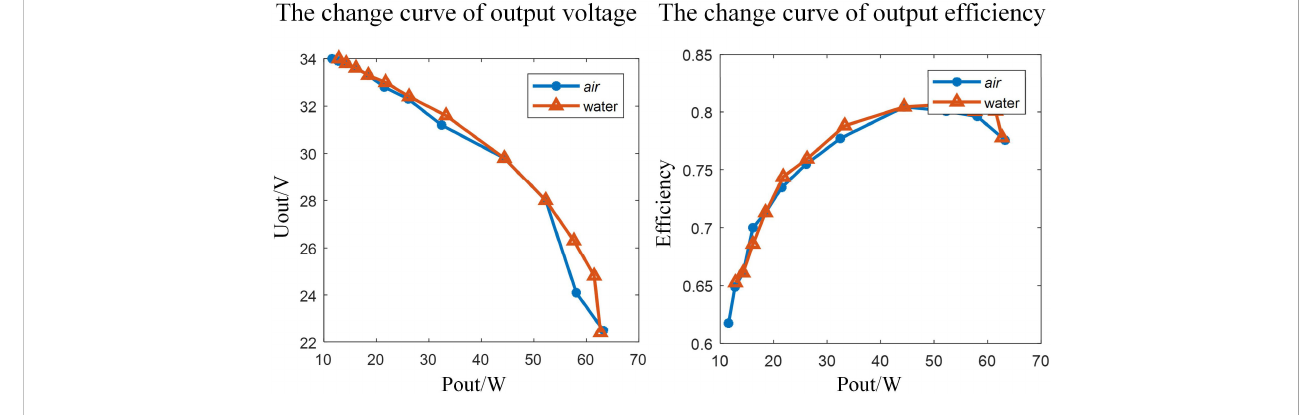
FIGURE 14 The power transmission performance of OCPT-NWMC in the water tool